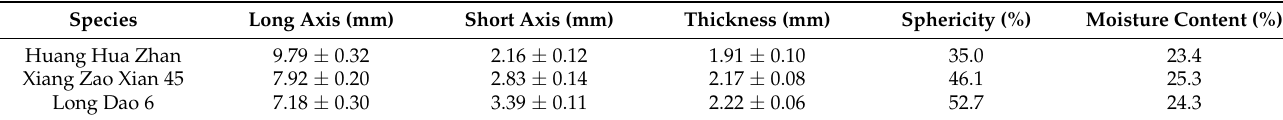
Table 1. The basic parameters of the experimental